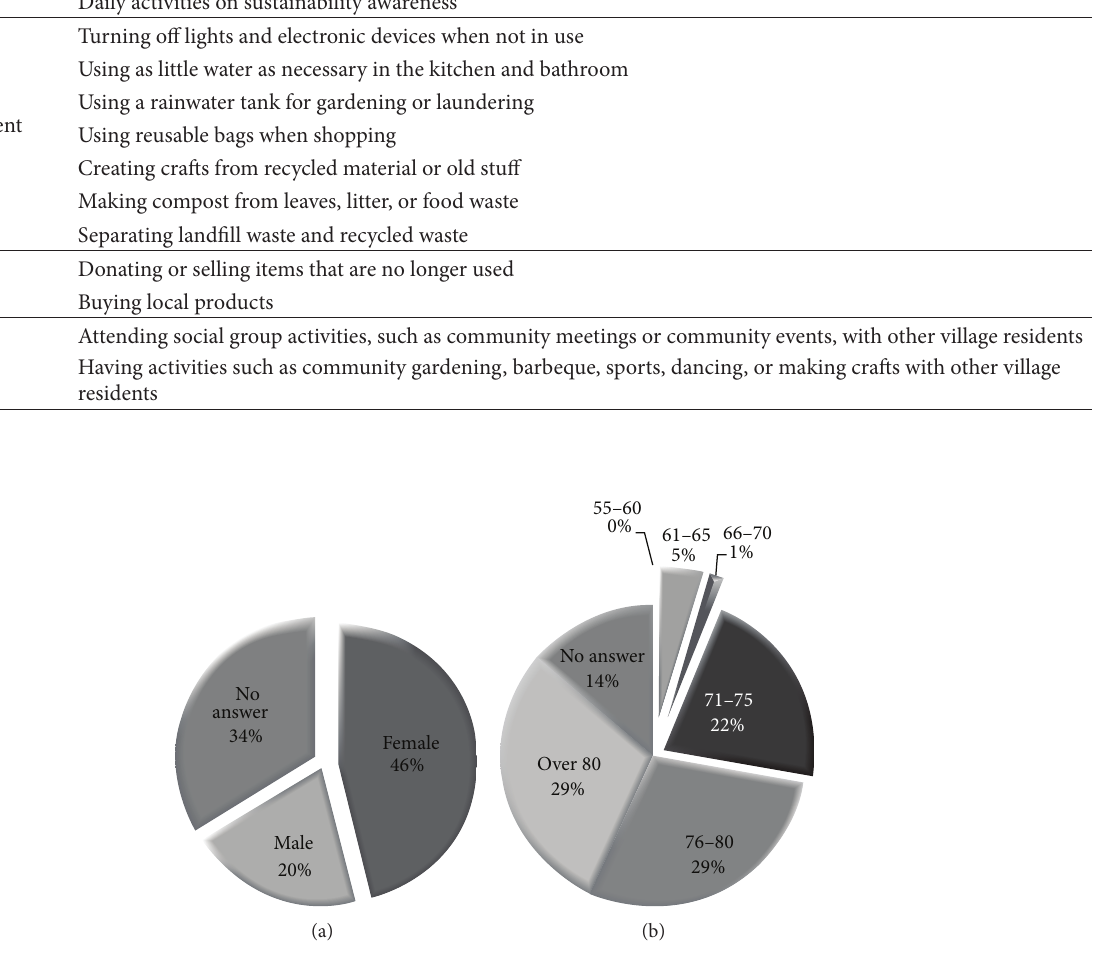
Figure 1: (a) Respondents’ gender distribution. (b) Respondents’ age